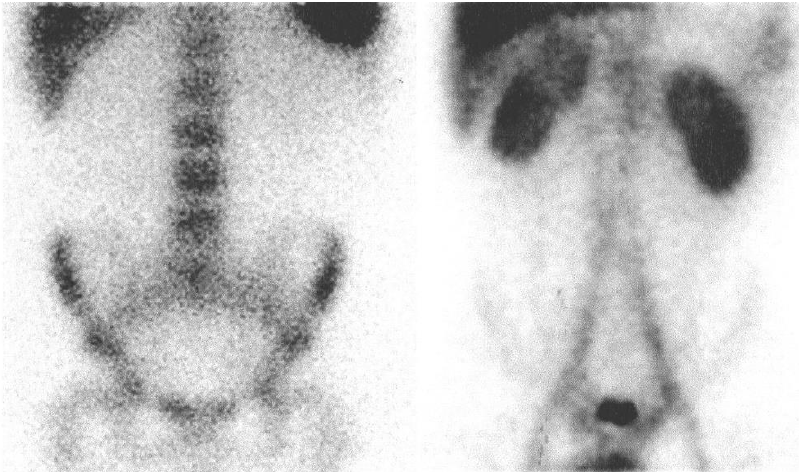
Figure 5. Comparison of 111 In-oxine labeled leukocyte scan (left) and 99mTc-labeled human immunoglobulin G scan (right) in the same patient (anterior view). The images do not show areas of pathological concentration of both radiopharmaceuticals.